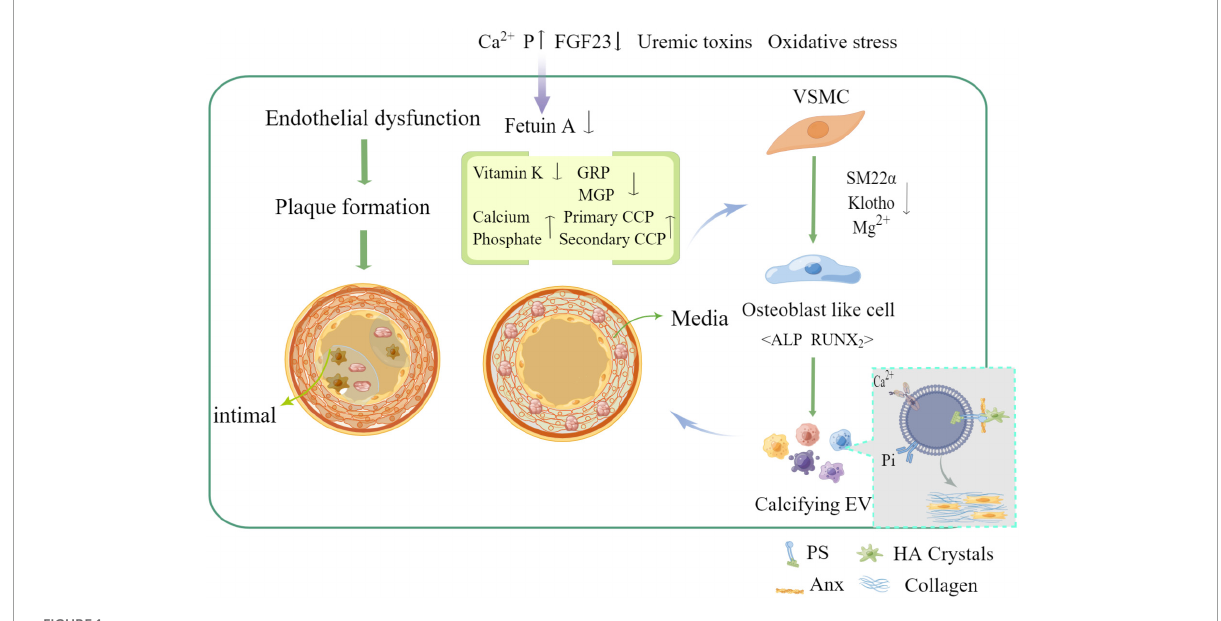
FIGURE1 Mechanism of vascular calcification formation and related influencing factors (by Figdraw).